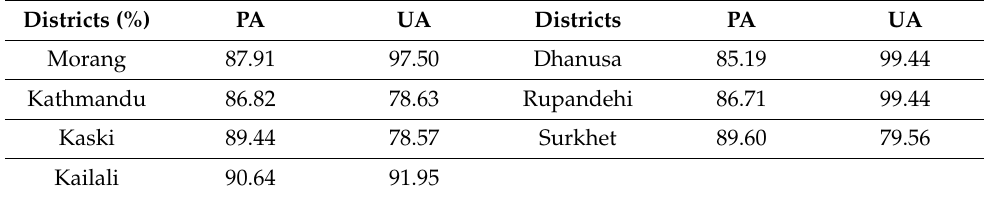
Table 6. Producer’s accuracy (PA) and User’s accuracy (UA) of farmland simulated by the CA-Markov model with the adaptive land suitability